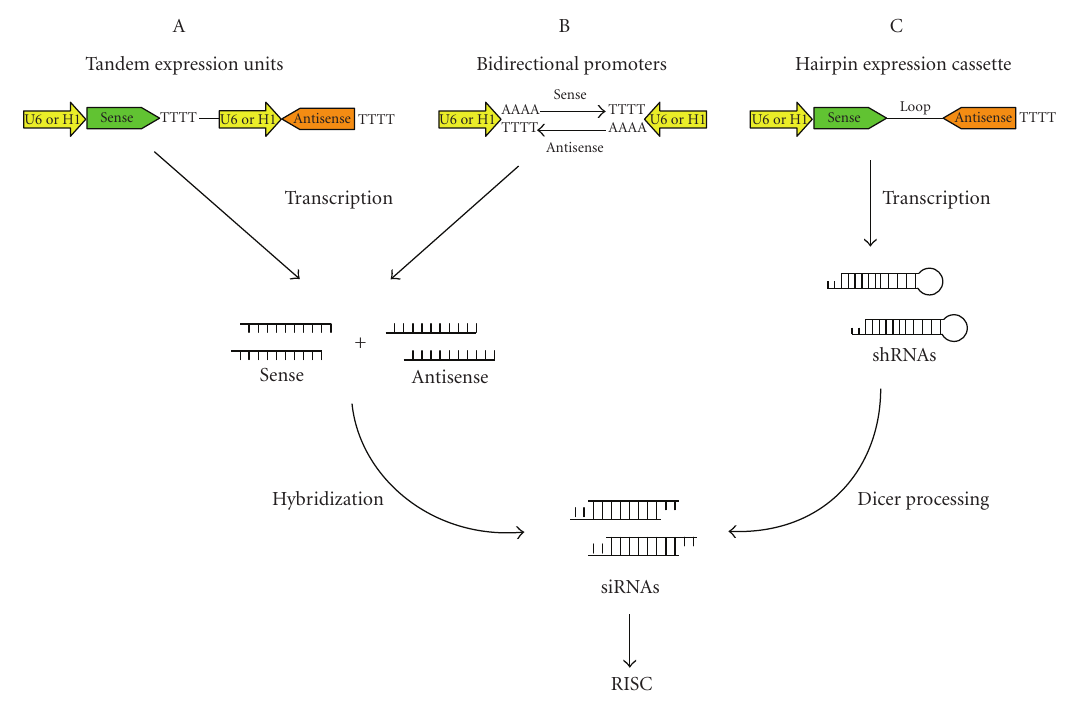
Figure 2: Schematic representation of vector-based RNAi . The two strands of an siRNA can be transcribed from two tandem expression units where the expression of the sense and the antisense strands is driven separately by their own respective promoter (A), or from a single DNA fragment under the control of two opposite promoters (B). After intracellular expression, hybridization of the two strands gives rise to functional siRNA duplexes. shRNAs are transcribed as single-stranded RNAs from a hairpin expression cassette cloned immediately downstream of an RNA pol III promoter containing the sense strand homologue to the target of interest followed by a 4 to 9nt spacer, the antisense strand, and the terminator signal. After transcription the resultant stem-loop structure is cleaved by Dicer and yields a functional siRNA